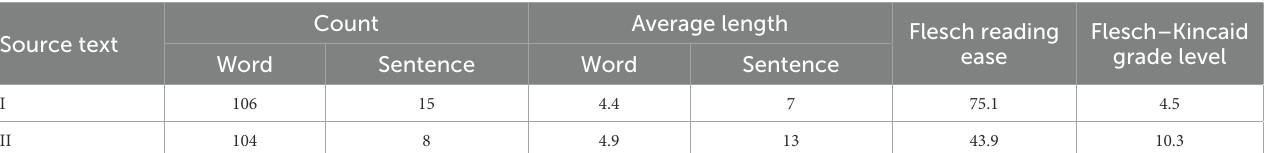
TABLE 1 Readability statistics of the two source texts.